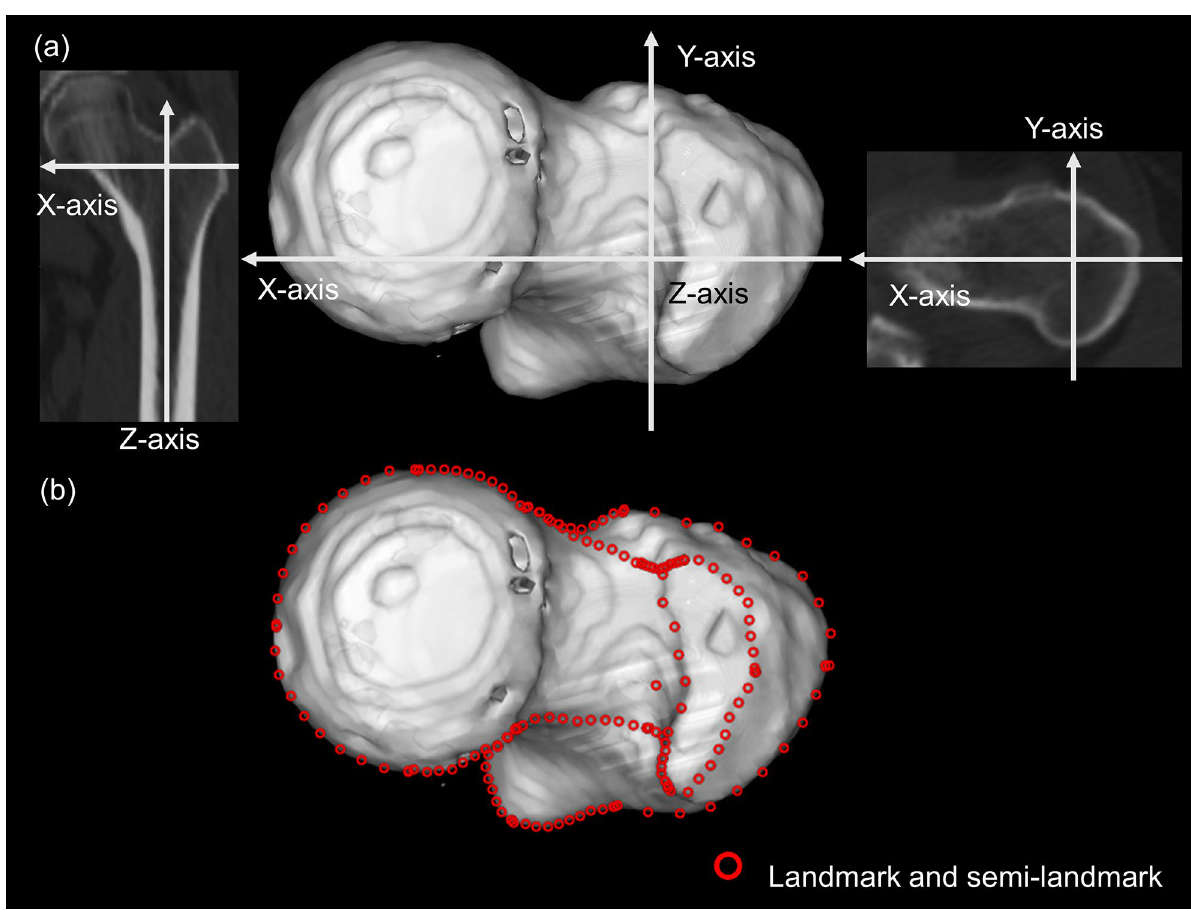
Figure 2. ( a ) The coordinate system of the proximal femur, in which the z-axis was defined as the line through the centre of the proximal femoral canal, the x-axis as the line parallel to the native anteversion through the z-axis, and the y-axis was perpendicular to the x- and z-axes. ( b ) Using this coordinate system, the morphology of the superior aspect of the proximal femur was analysed. Landmarks were placed on the inflection point of the femur; the detailed landmark positions are shown in Table 1. One hundred fifty semi-landmarks on the femur were manually placed and then automatically repositioned as equidistant